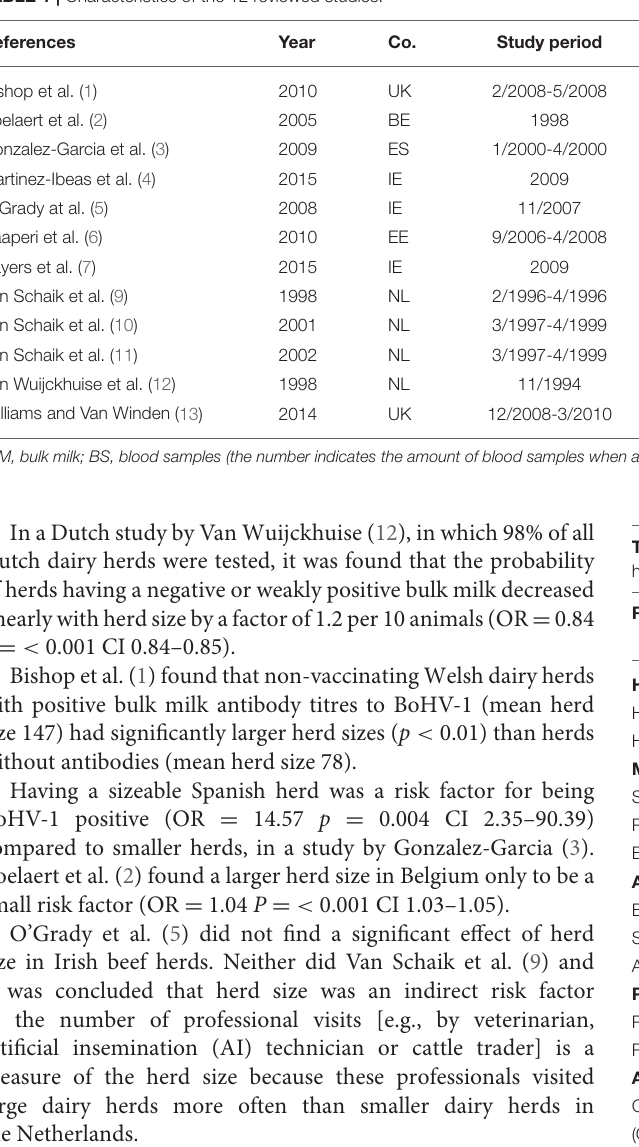
TABLE 1 | Characteristics of the 12 reviewed studies.